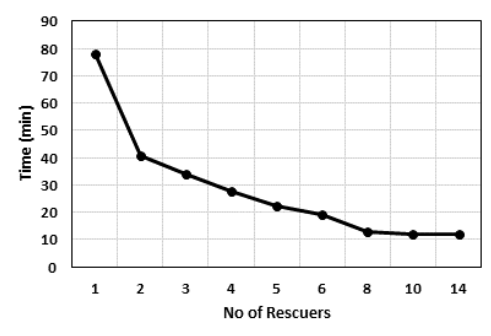
Figure 10. Time to finish